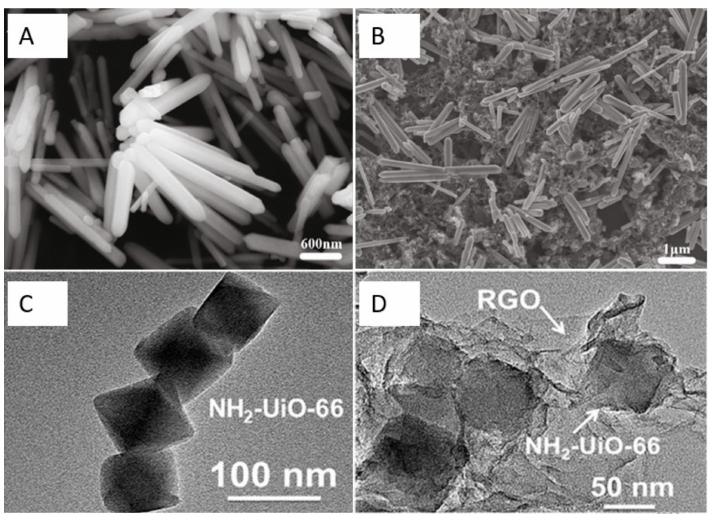
Figure 2. ( A , B ) SEM images of ZnO nanorods and Gr-ZnO nanocomposites, respectively. Adapted with permission from Ref. [44]. Copyright 2020 Elsevier. ( C , D ) TEM images of NH2–UiO-66 and NH2–UiO-66/RGO, respectively. Adapted with permission from Ref. [52]. Copyright 2019